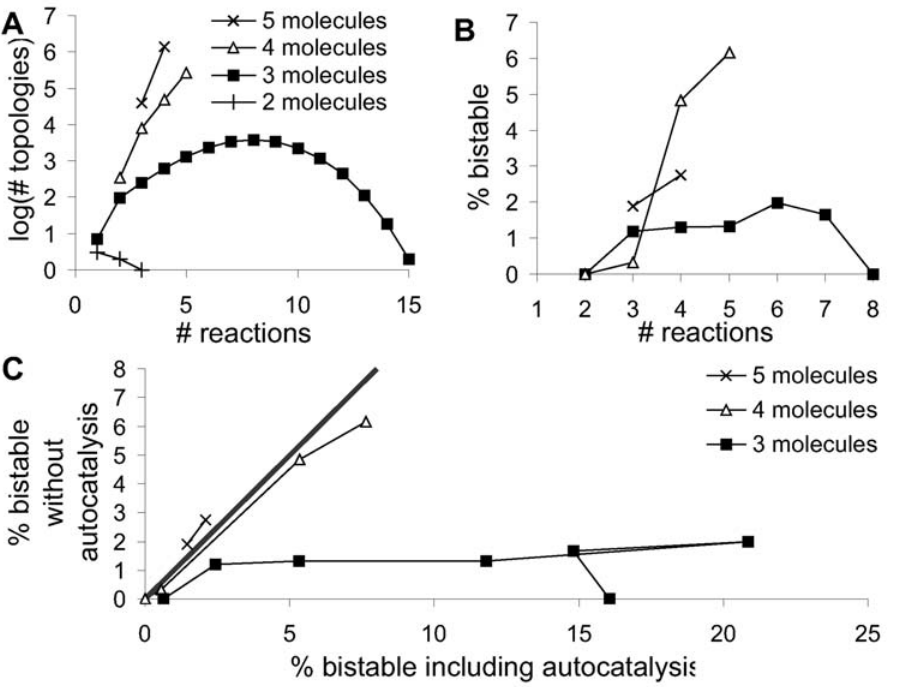
Figure 3. Effects of Autocatalysis. (A) Number of nonautocatalytic configurations as a function of number of reactions. (B) Percentage of bistable configurations for 3, 4, and 5 molecules as a function of number of reactions. Same symbols as in (A). (C) Comparison of bistability percentage for entire dataset ( x axis) and set without autocatalysis ( y axis). The thick line indicates equal percentages. 3-molecule systems have fewer bistables without autocatalysis, but 4 and 5 molecule systems have nearly equal bistables if autocatalytic reactions are excluded. The different points on each plot are for numbers of reactions. As bistability declines for large reaction numbers for 3 molecules, this curve folds back on itself.